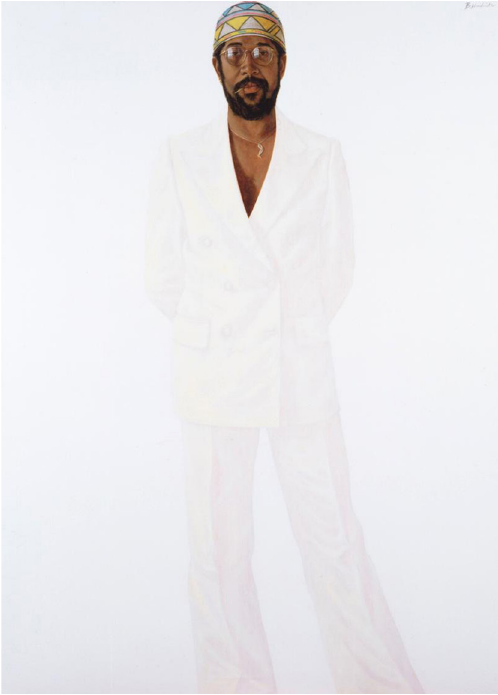
Figure 15. Hendricks, Barkley L. Slick (Self-Portrait) (1977). Oil, acrylic, and magna on linen canvas, 72 x 48 inches. ©Estate